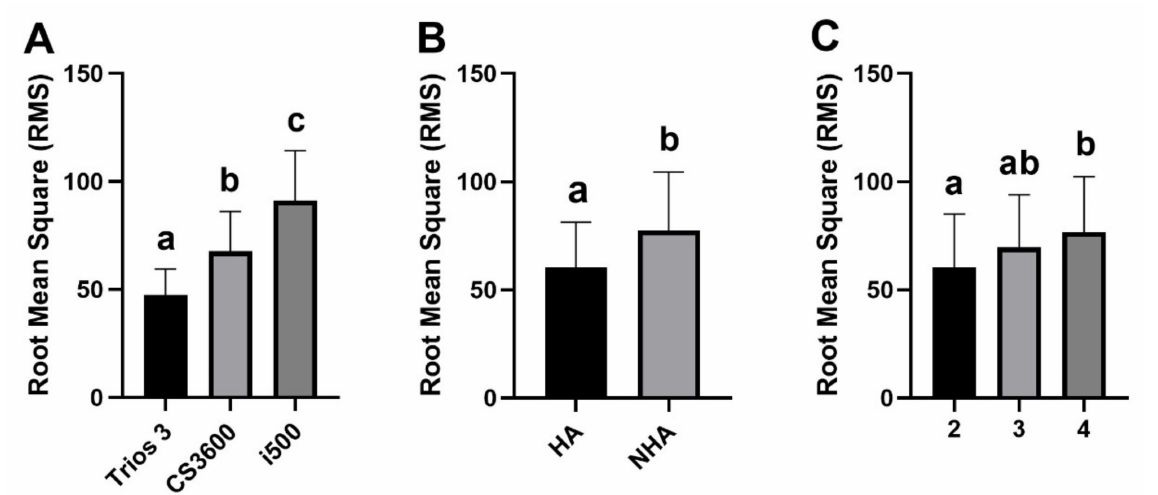
Figure 4. Results of the three-way ANOVAs of trueness ( A ) between the groups with different scanners, ( B ) between the groups with or without healing abutment, and ( C ) between the groups with different numbers of missing teeth. The number on the x-axis in panel C stands for the number of missing teeth. Different letters indicate significant differences between two groups. Data are mean and standard deviation values in micrometers. Table 1. Trueness values in the HA-2, HA-3, HA-4, NHA- 2, NHA-3, and NHA-4 groups for the three intraoral scanners (IOSs). Eight scans were performed in each group. Data are mean ± standard deviation values in micrometers. IOS HA-2